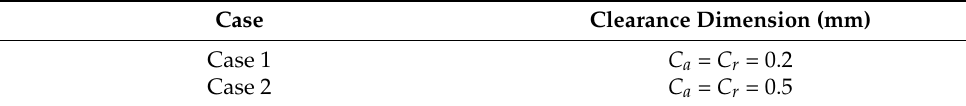
Table 4. Clearance dimension of joint B.